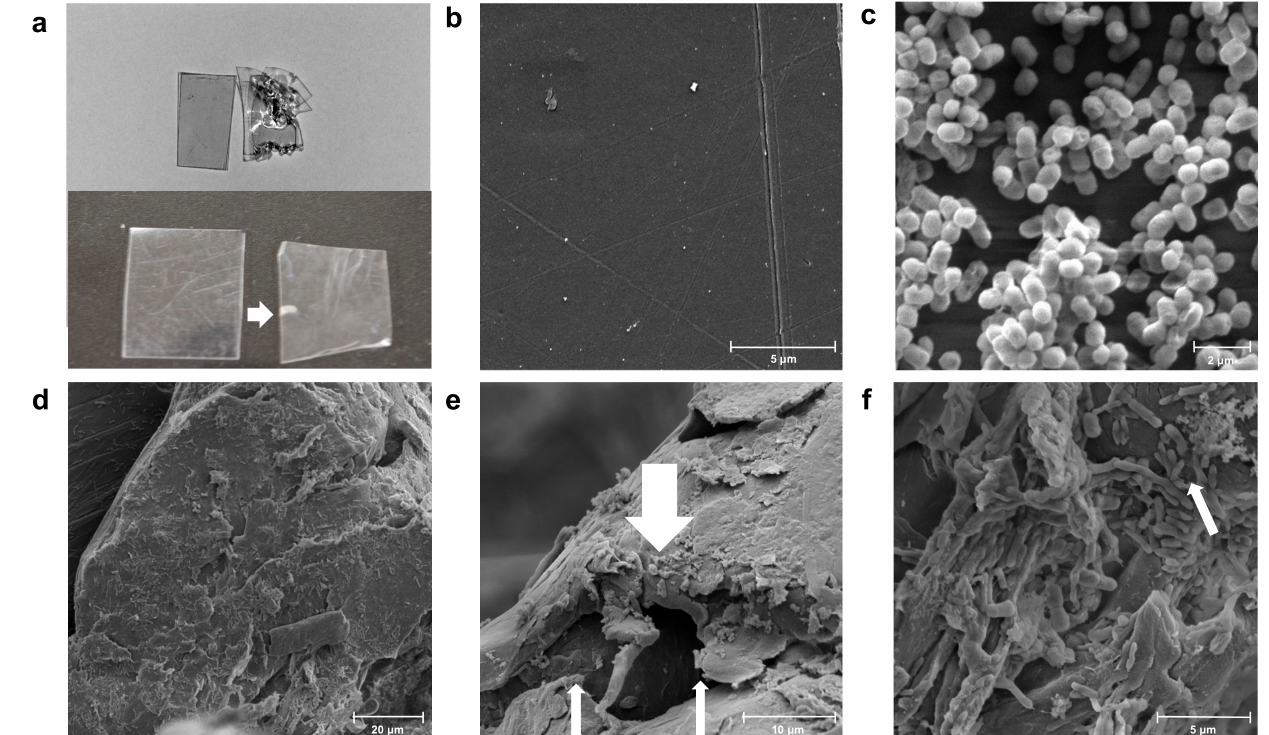
Figure 2. Macroscopic and microscopic images of polystyrene (PS) degradation by Exiguobacterium sp. RIT 594. ( a ) Macroscopic images of circa 2 × 3 cm pieces cut from PS plates (0.19 mm thickness); top left and bottom left = sterile control; top right and bottom right = incubated in shaking cultures of Exiguobacterium sp. RIT 594. The samples were incubated for 21 (top) or 35 (bottom) days. The pattern of degradation varies with each sample: the top one shows visible holes, while the bottom one shows opaque notches indicated by a white arrow. ( b – f ) SEM images with resolutions indicated. ( b ) PS control without bacterium (11,700 × resolution, scale bar 5 µ m); ( c ) pure cultures of Exiguobacterium sp. RIT 594 grown in liquid media (LB) without PS and deposited on a cover slip (16,000 × resolution, scale bar 2 µ m) are seen as cocci. ( d – f ) Increasing magnification of the white notch from the plate on bottom right in ( a ) at ( d ) 1990 × resolution, scale bar 20 µ m; ( e ) 5240 × resolution, scale bar 10 µ m (note the areas where the polymer is eaten away as indicated by the thinner arrows and the bacterium on the polymer by thicker arrows); and ( f ) 10,300 × resolution, scale bar 5 µ m, where the white arrow points to the shortened rods in the biofilm with characteristic fibers and nanoparticles generated during